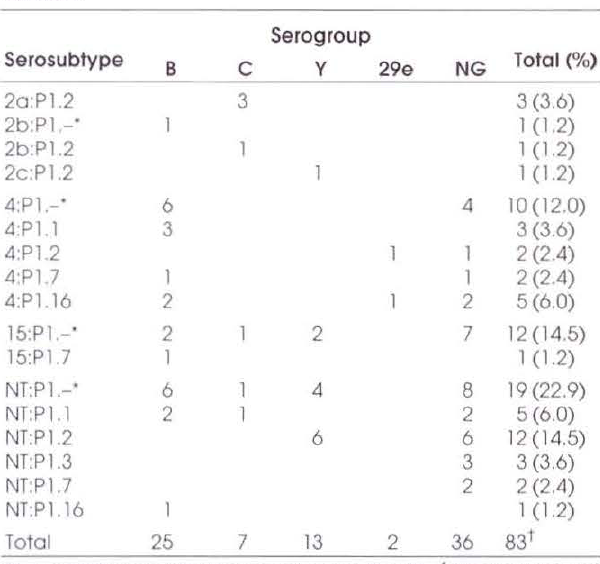
Distribution of serosubtypes among serogroups of Neis- seria meningitidis in the selected asymptomatic pop -